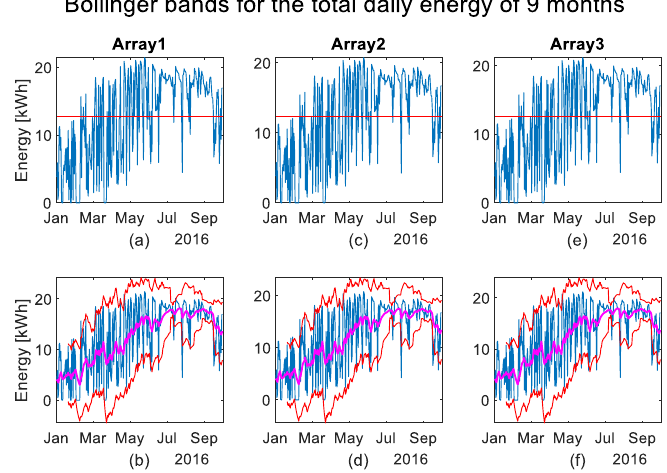
Figure 6. ( a ) Energy produced by array #4 in six months and its mean value as red line; ( b ) upper and lower BB 20 of array #4 in red color, and EMA 20 in magenta color. ( c ) and ( d ) refer to array #5. ( e ) and ( f ) refer to array #6. Table 2. Mean energy and spread with respect to the global mean for the semester analysis.